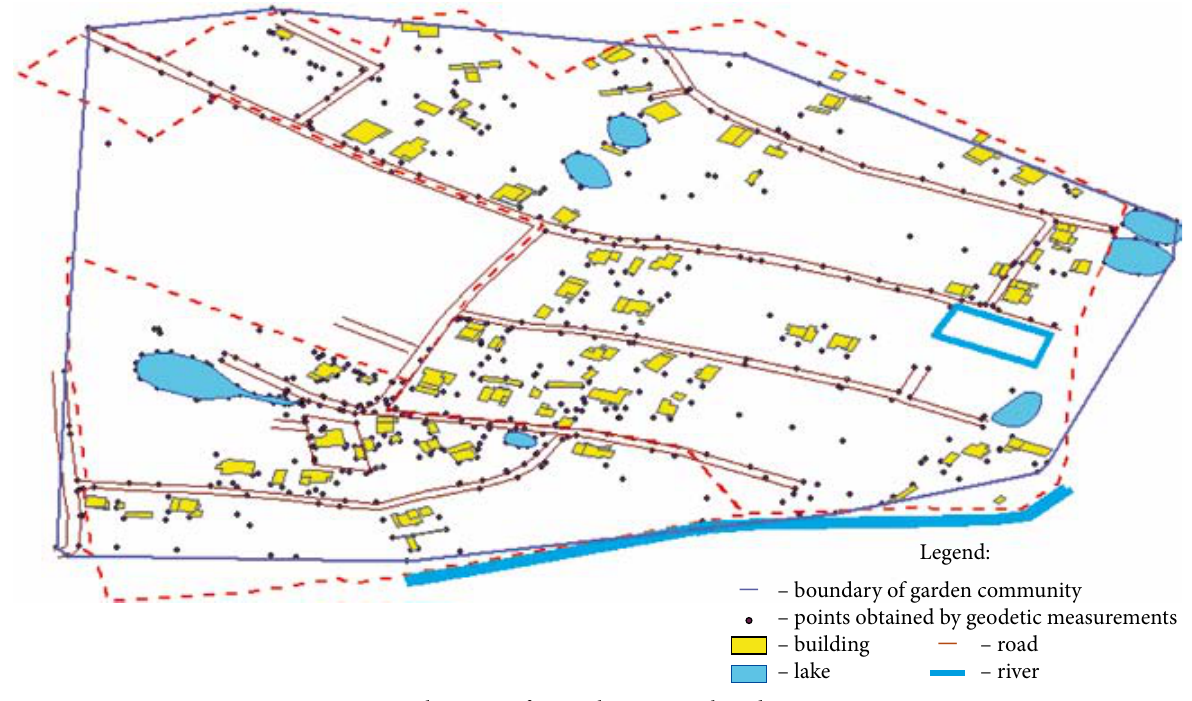
Fig. 3. Placement of main objects in a selected